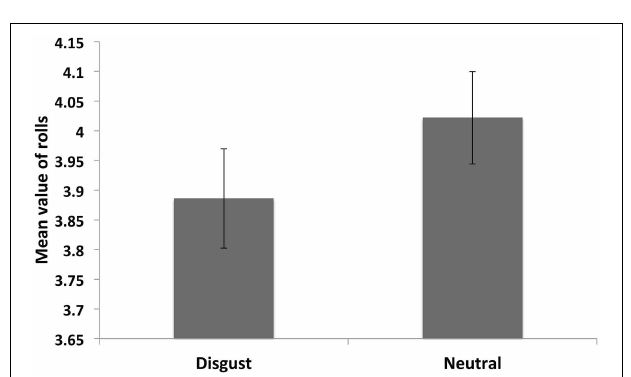
p > 0 . 0125 after correction for multiple comparisons for the 4